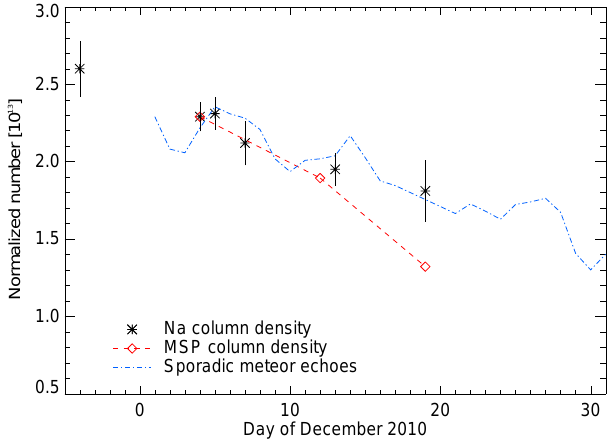
Fig. 10. Comparison of sporadic meteor echoes (blue dash-dot line), Na column density (black asterisks; error bars indicate the standard deviation of the geophysical variability), and MSP column density (red diamonds) in December 2010. The y-axis is correct for Na col- umn density in m − 2 . The values must be multiplied by 2 . 27 × 10 − 2 for absolute MSP column density. The values multiplied by 3 . 75 − 10 give the correct number of observed sporadic meteor echoes. The number of meteor echoes on 17 to 19 December is interpolated, be- cause the radar was out of order on these days.